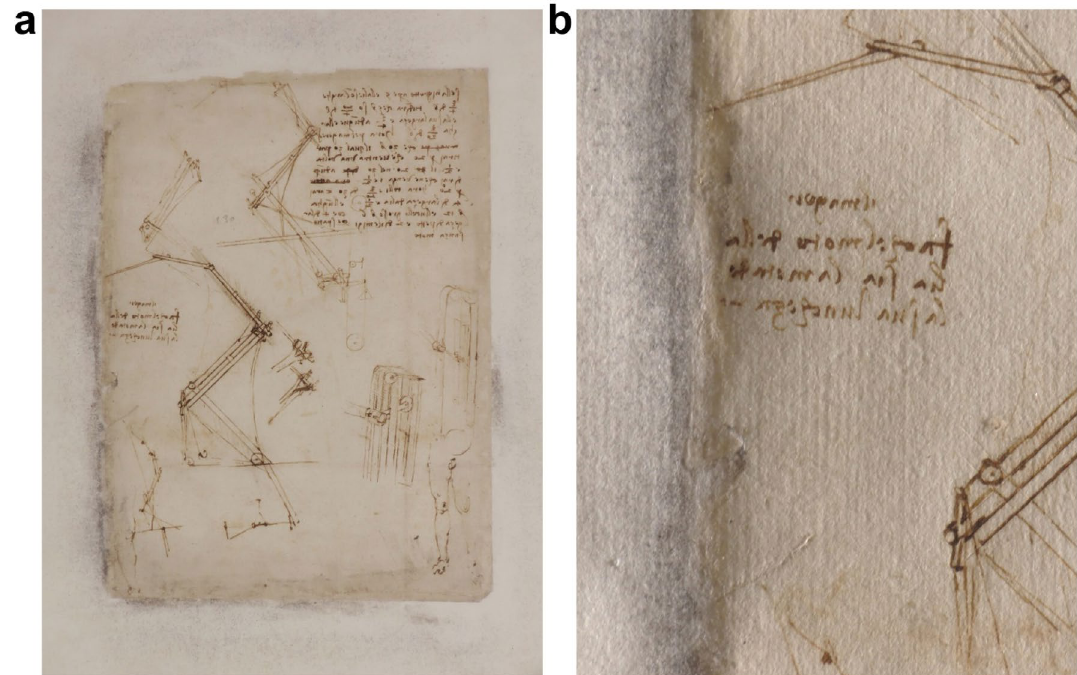
Figure 1. Recto of Folio 843 (Leonardo’s folio size 29.6 × 22.1 cm). ( a ) Condition of Folio 843 in May 2021. ( b ) Detail of the black stains in the central area on the left margin (images courtesy of restorer Dr. Vito